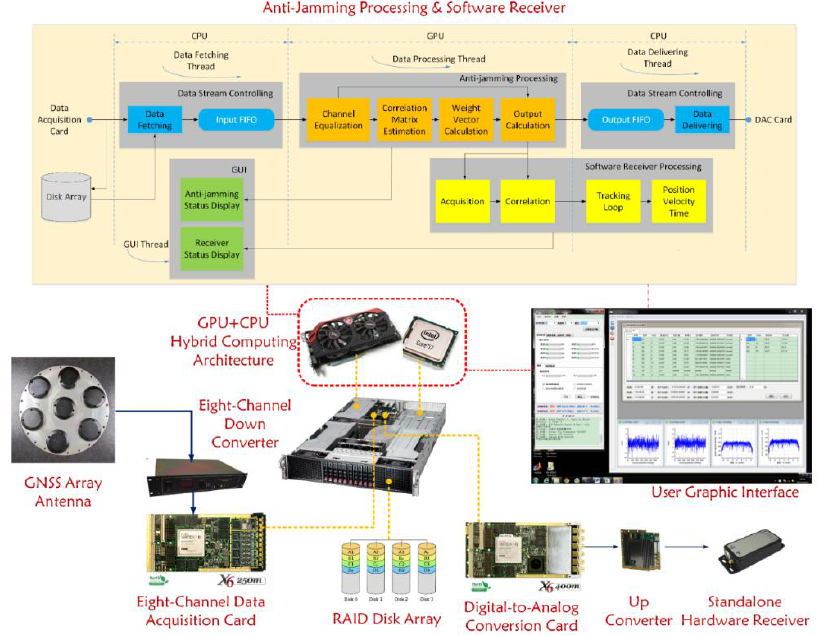
Figure 11. The complete schematic picture of the real-time testbed for adaptive GNSS array anti-jamming.